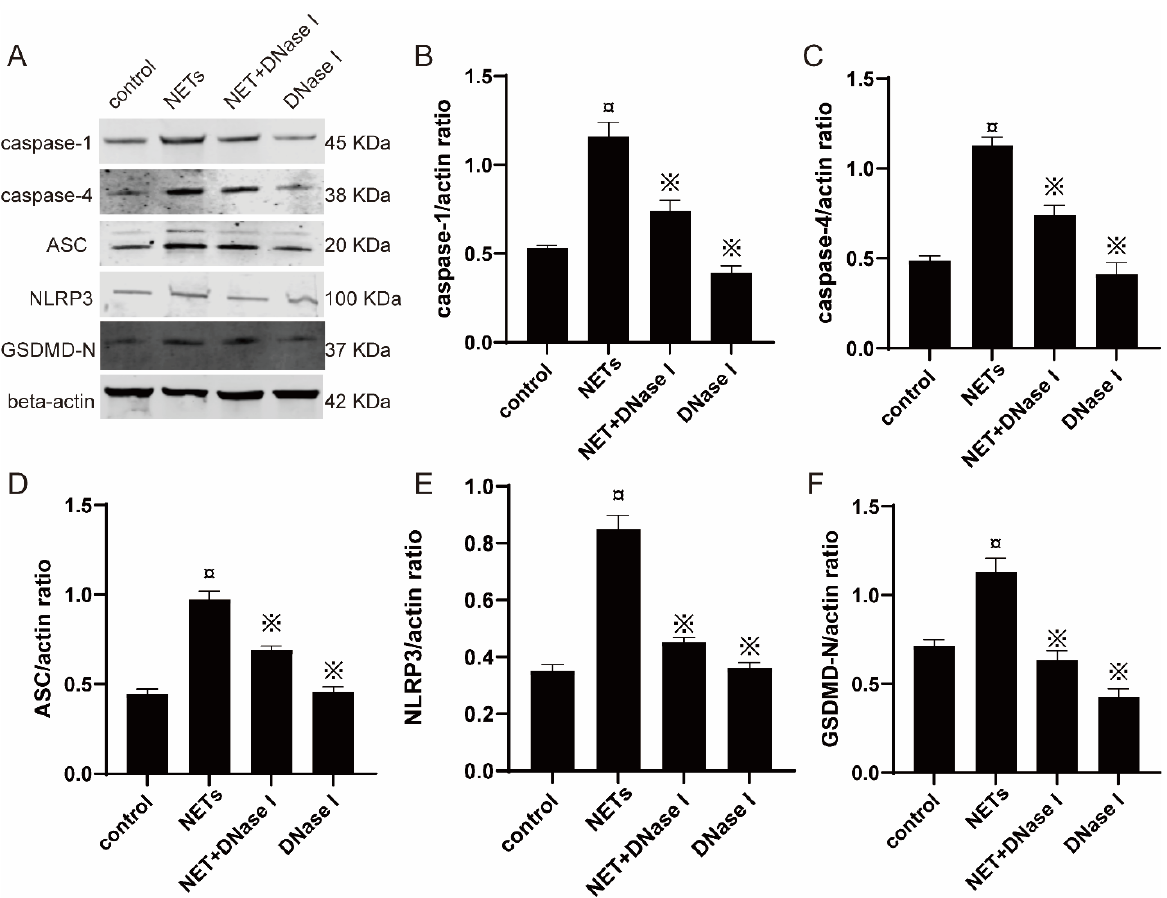
Figure 8. Expression of caspase-1, caspase-4, ASC, GSDMD-N, and NLRP3 in BEECs was detected by Western blotting. ( A ) The expression blots of pyroptosis-related proteins, including caspase-1, caspase-4, ASC, GSDMD, and NLRP3, with varying molecular weights. Western blot analysis of ( B ) caspase-1, ( C ) caspase-4, ( D ) ASC, ( E ) NLRP3, and ( F ) GSDMD-N in the treatment groups ( n = 3). The gray values in the figure were analyzed using Image J. Values are presented as the mean ± SD. ¤ p < 0.05 vs. control group and ※ p < 0.05 vs. NET without DNase I.